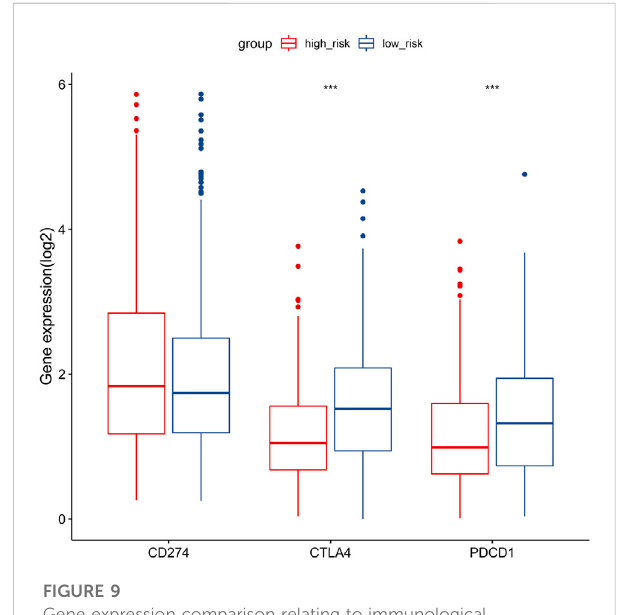
FIGURE 9 Gene expression comparison relating to immunological checkpoints in the two categories. Middle line of the box represents the median of the data, while the upper and lower limits of the box represent the upper and lower quartiles of the data, the line extending from the box represents 1.5 times the interquartile range (IQR) from the upper and lower quartiles. * p < 0.05; ** p < 0.01; *** p <